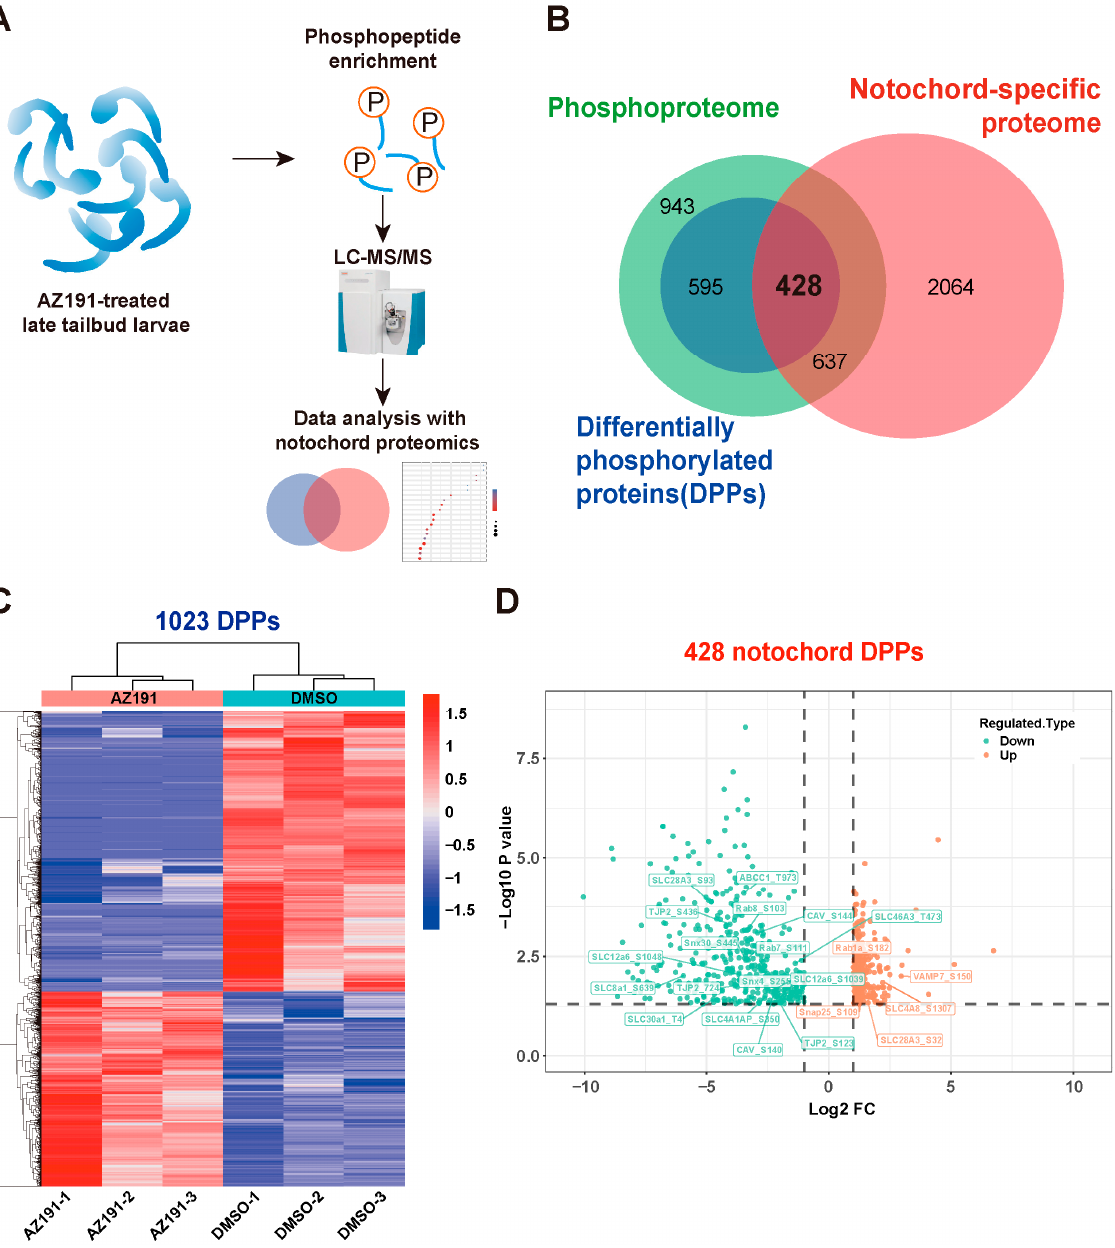
Figure 2. Phosphoproteomic analysis of AZ191-treated late tailbud larvae of Ciona . ( A ) Work fl ow of AZ191-treated late tailbud larvae collection, phosphopeptide enrichment, mass spectrometry, and phosphoproteomic analysis. ( B ) Venn diagram showing overlapped phosphoproteins between the phosphoproteomics and notochord proteomics. ( C ) Heatmap of DPPs in the inhibitor AZ191-treated group versus the control group. Rows represent the abundance ratio values of proteins, and col- umns represent individual samples (three biological replicates for each group). The colored bars show the row-standardized signal values: the red representing high and the blue representing low phosphorylation levels. ( D ) Volcano plot of the phosphorylation levels of 699 phosphosites of 428 DPPs speci fi cally expressed in notochord tissue. The orange points indicate upregulated phospho- proteins, while green points indicate downregulated phosphoproteins. p value < 0.05.